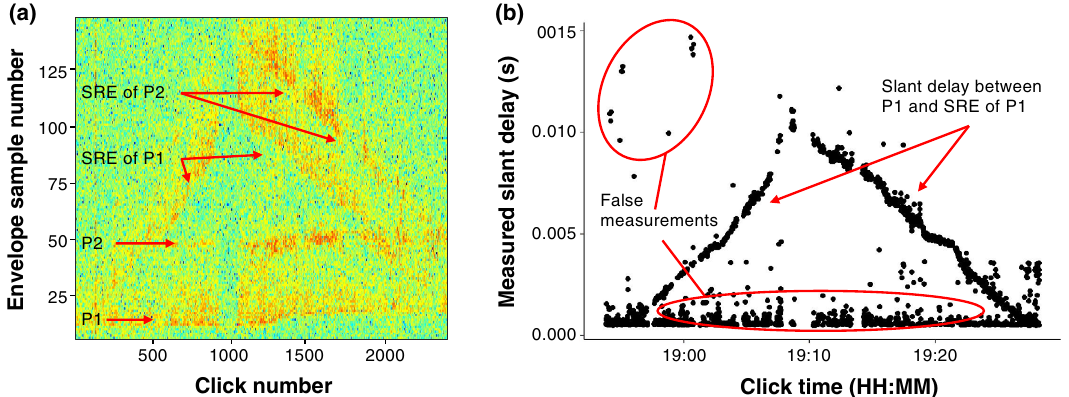
Figure 2. ( a ) Echogram illustrating the energy recorded in the 0.015 s after each of 2425 clicks in an event. The vertical axis includes 144 samples at a decimated frequency of 9600 Hz (0.015 s). The P1 and P2 pulses of the direct click are visible as are the surface reflected echoes (SRE) of these pulses. ( b ) Plot of the measured slant delay (s) over the click time (HH:MM). Slant delay increases to ~ 0.01 s and then decreases over a time period of approximately 34.5 min. Some of the false measurements of slant delay, not consistent with the pattern, are